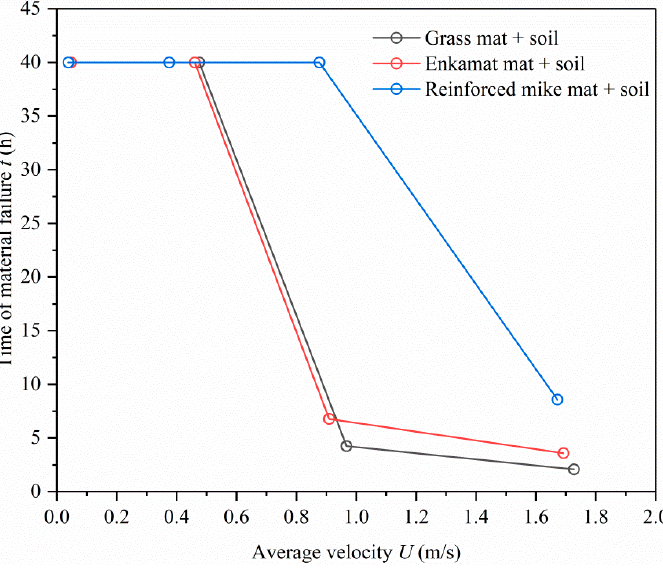
Figure 10. Anti-scour properties of slope protection mat